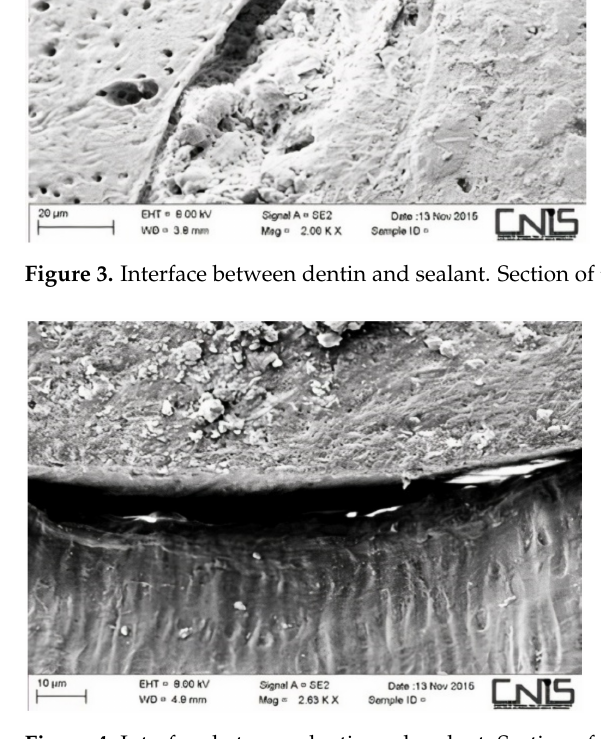
Figure 4. Interface between dentin and sealant. Section of medium third T